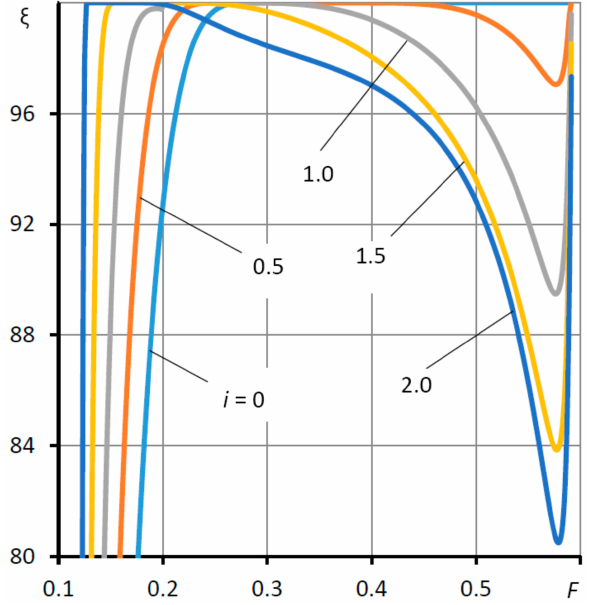
Figure 10. Dependences of the oscillation damping criterion for the period ξ on the load F at different values of the elasticity coefficient K e = i K e 0 .